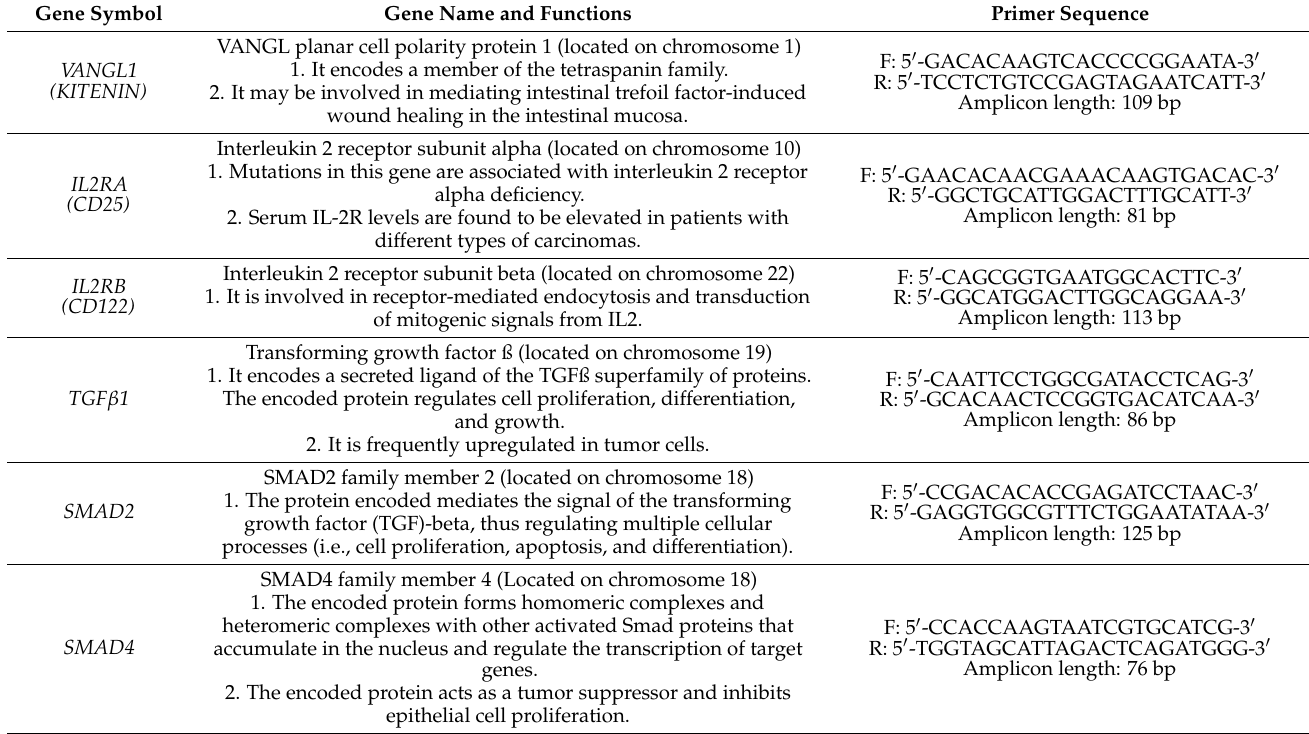
Table 1. Information * on the biological functions of 20 candidate genes and on the primer sequences used for RT-qPCR Gene Symbol Gene Name and Functions Primer Sequence VANGL1